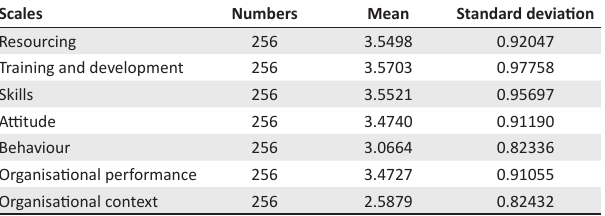
TABLE 1: Descriptive